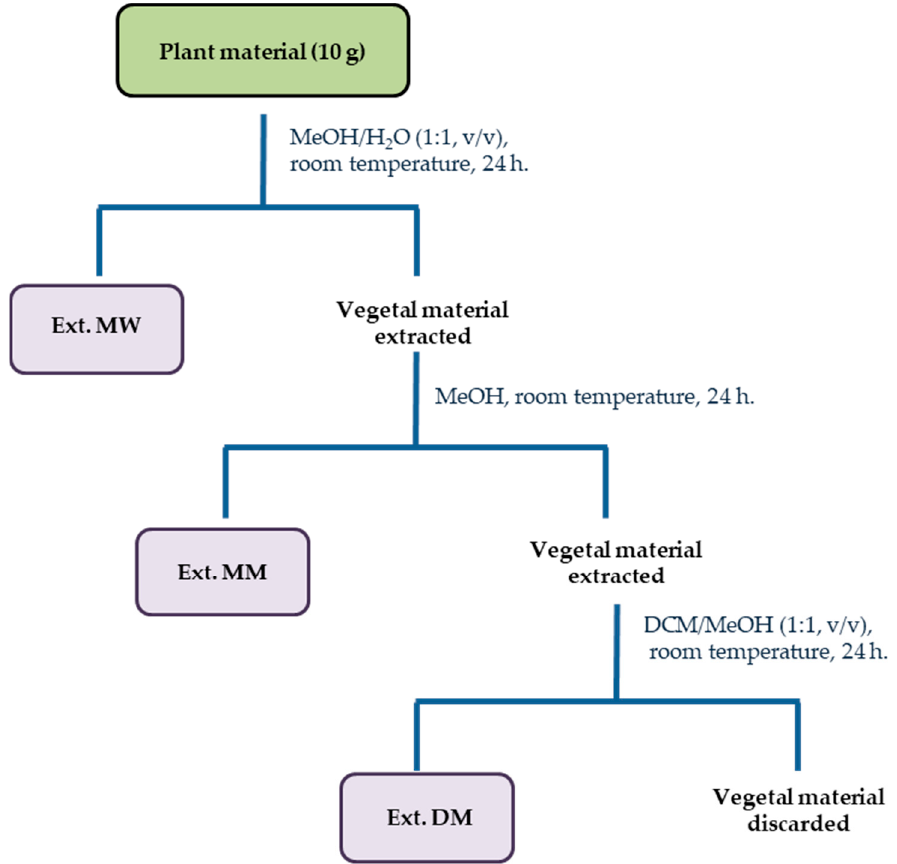
Figure 1. Workflow procedure for the preparation of microextracts from aerial parts of Hypericum species from the Canary Islands.